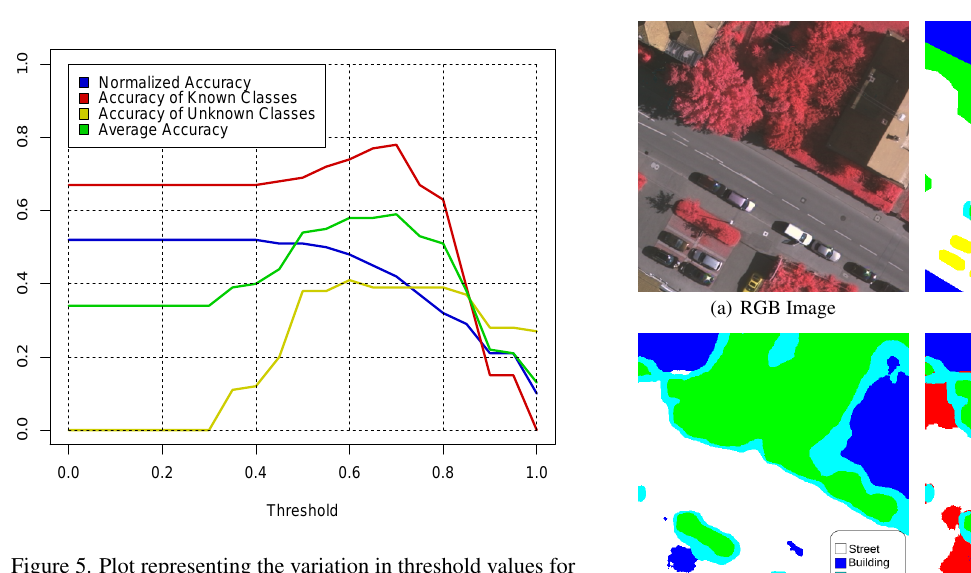
Figure 5. Plot representing the variation in threshold values for OpenPixel and its impact in evaluation metrics.